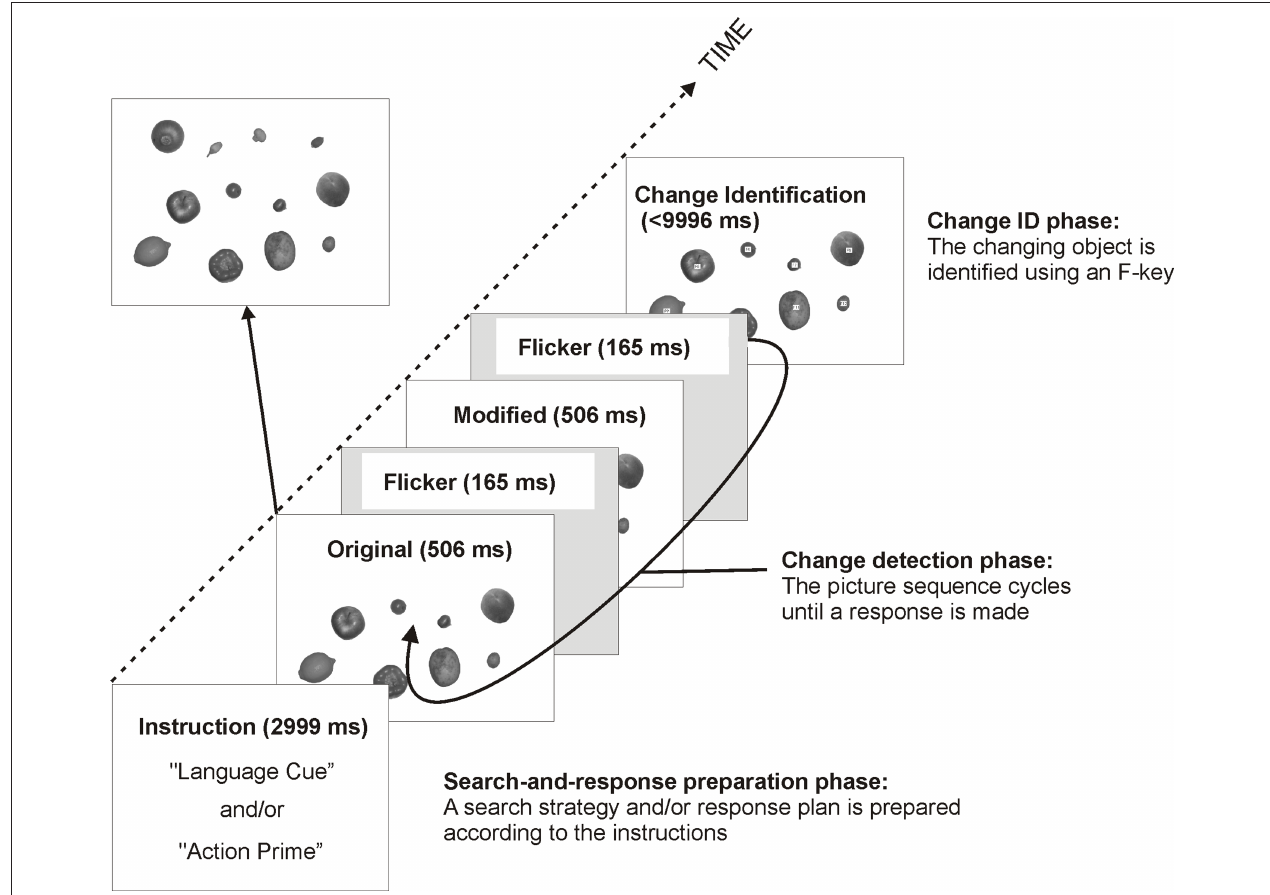
FigurE 1 | Schematic illustration of the sequence and timings of the displays in all four experiments (adapted from Symes et al., 2008) . In Experiment 1, the instruction consisted of only a language cue, whereas in the remaining experiments it consisted of a language cue and an action